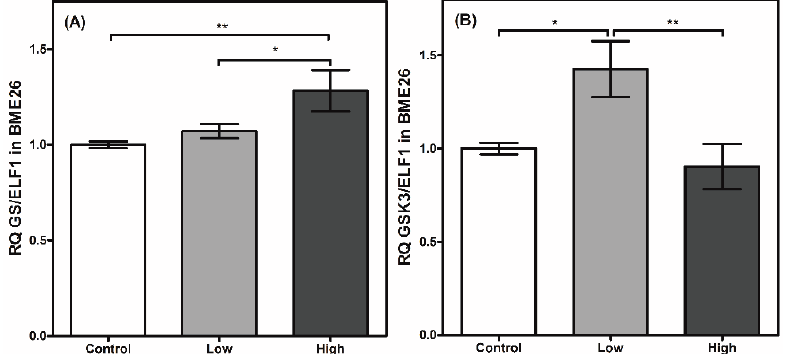
Figure 5. Glycogen metabolism synthesis has a transcriptional control in BME26 cells. Transcriptional analysis of glycogen synthase ( A ) and glycogen synthase kinase 3 ( B ) in embryonic Rhipicephalus microplus cells (BME26) in response to glucose treatment. Control: cells maintained with 50 mM of glucose; Low: cell maintained without glucose addition; and High: cells maintained with 100 mM of glucose. The experiment was performed with three independent biological samples in three experimental replicates each ( * p < 0.05; ** p < 0.001, ANOVA).